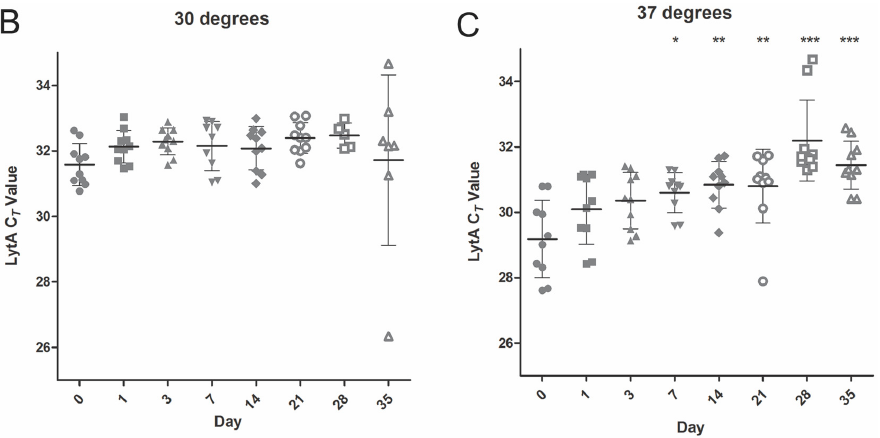
Figure 2. Pneumococcal signal in DSS is stable over long periods of time. Mock DSS specimens from saliva ( n = 5 donors per experiment) spiked with S. pneumoniae serotype 19F. ( A ) DNA was isolated immediately after drying (day 0) and after storing the DSS at the indicated temperatures for up to 35 days. Shown are the mean and SD of all cycle threshold (C T ) values. For 30 ˝ C, room temperature, 4 or ´ 20 ˝ C, no significant differences were found for C T values of DSS stored over time compared to C T values at day zero; ( B ) Graph of individual DSS stored at 30 ˝ C; ( C ) Graph of individual DSS stored at 37 ˝ C for up to 35 days: a gradual loss of signal was observed at 37 ˝ C but not at ď 30 ˝ C (one-way ANOVA with Bonferroni post-test * p < 0.05, ** p < 0.001, *** p < 0.0001).